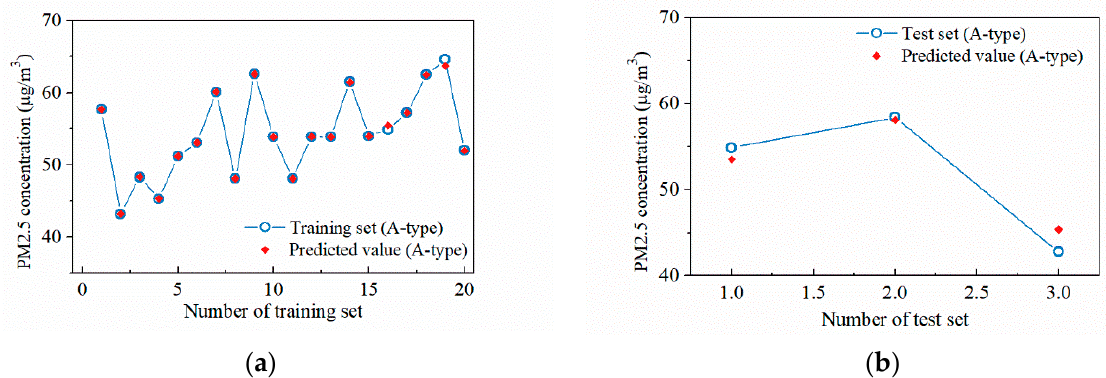
Figure 17. Regression result of the A-type sampling points at the concourse floor: ( a ) Training set; ( b ) Test set.